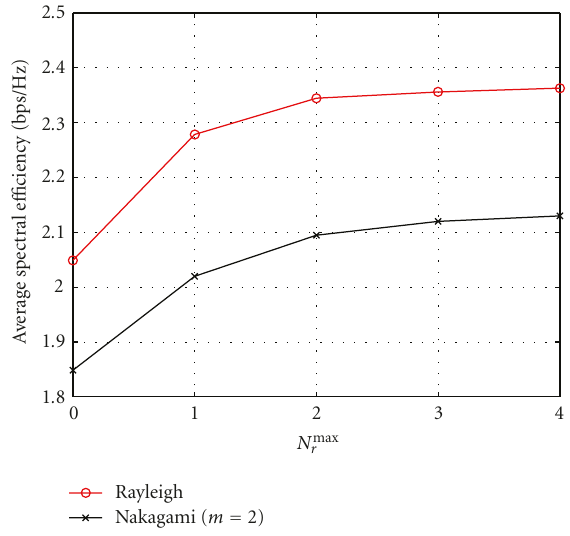
Figure 6: Average spectral e ffi ciency versus number of retransmis- sions, I max = 10 dB.